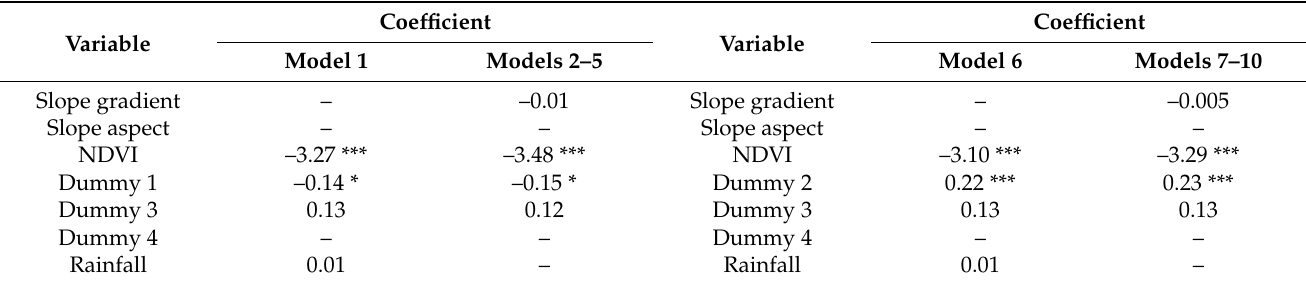
Table 2. The coefficients of selected independent variables by logistic regression analysis for models 1–10.